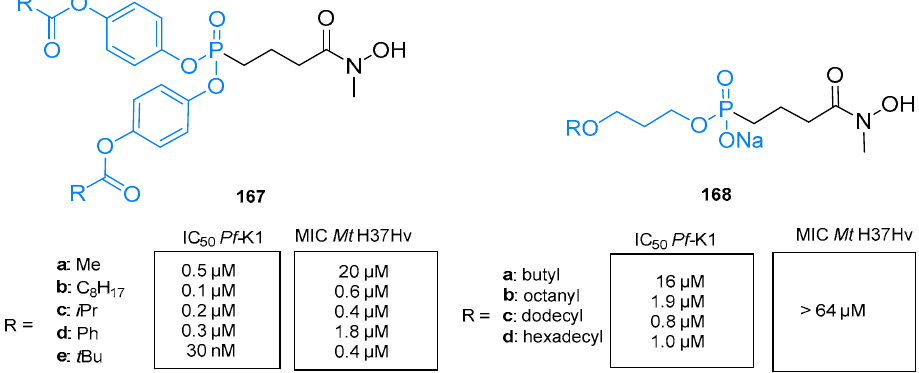
Figure 32. Antiplasmodial and antimycobacterial activity of acyloxybenzyl ( 157 ) and alkoxyalkyl phosphonate ester prodrugs ( 158 ).